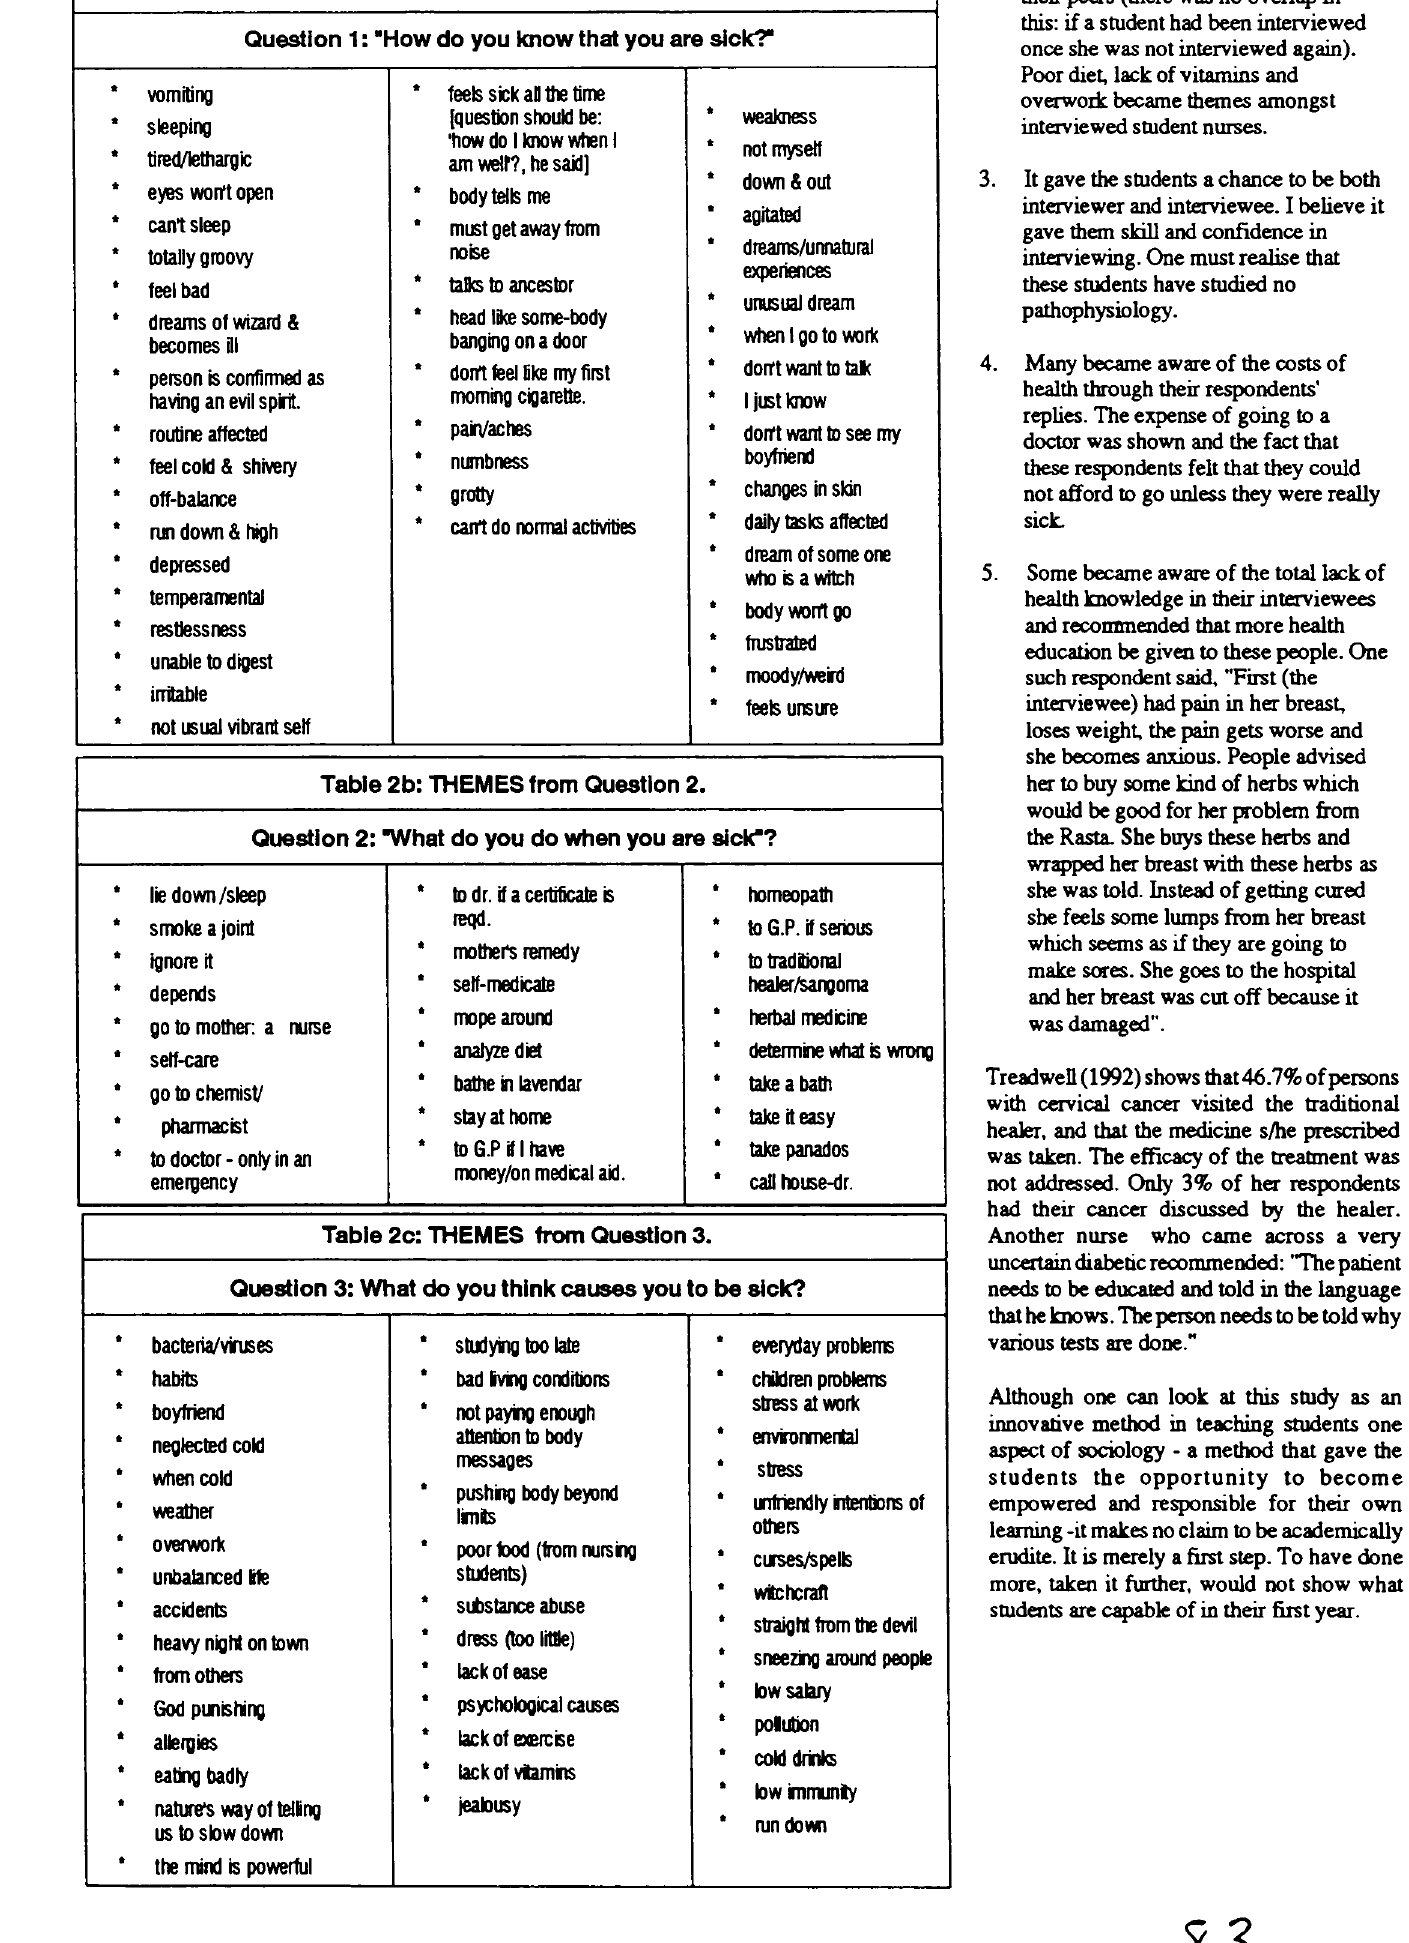
Table 2a: T1HEMES from Question 1.